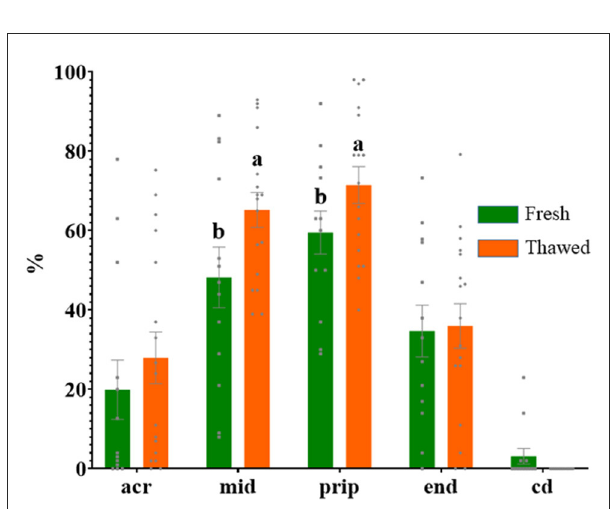
FIGURE4 Proportion (mean ± SEM) of fresh and frozen-thawed spermatozoa from ejaculates classified as of good freezability (GFE) with representative localization patterns of AQP3 in membrane domains. Acr, Acrosome; mid, midpiece; prip, principal piece; end, end piece; cd, cytoplasmic droplet. Different letters (a, b) indicate significant differences ( P < 0.05) between groups.